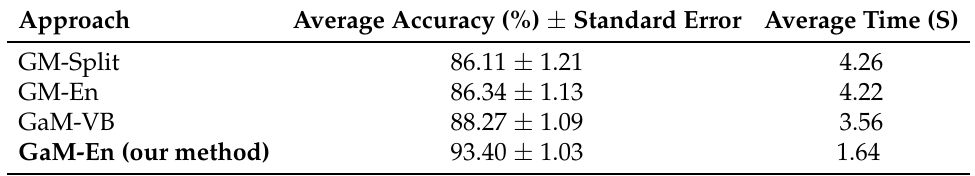
Table 1. Overall accuracy (% ± standard error) of dynamic texture clustering of different approaches using SIFT features on the DynTex